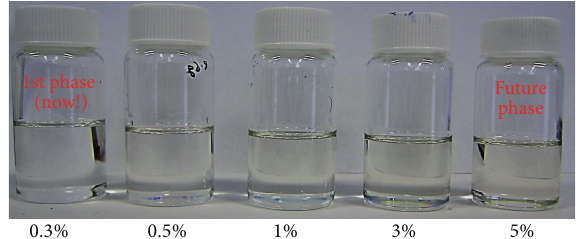
Figure 5: TeLS samples from the investigation of higher tellurium loading in LAB scintillator. The samples increase in loading from 0.3% (by weight) on the left to 5% on the